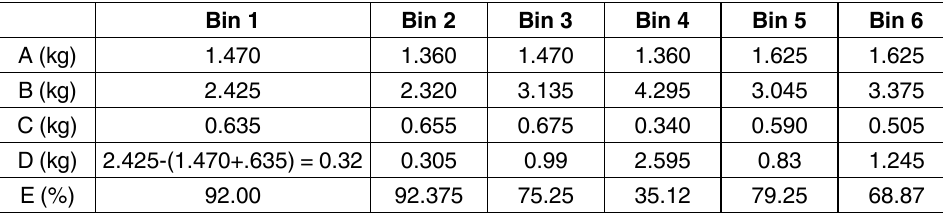
table 1. Parameters for assessing substrate